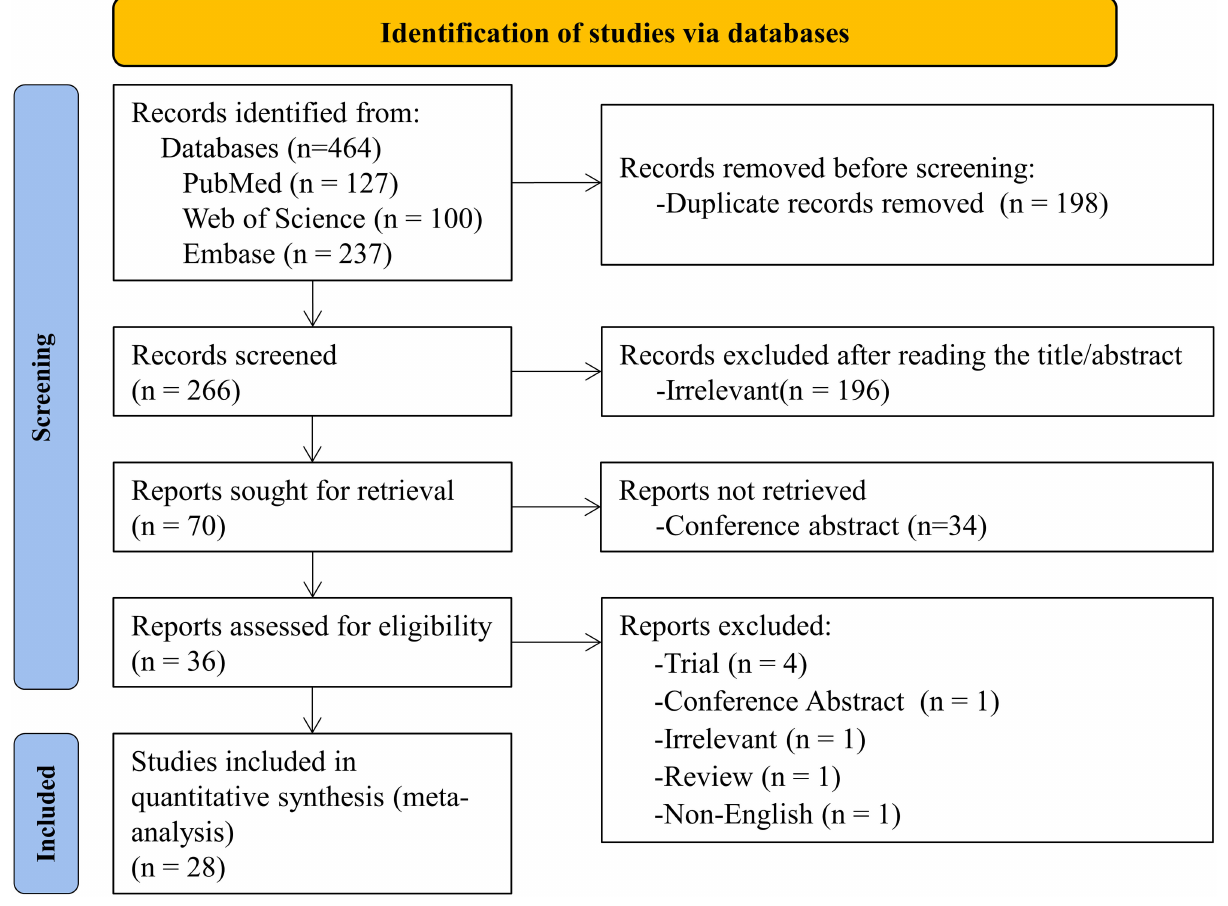
Frontiers in Medicine |